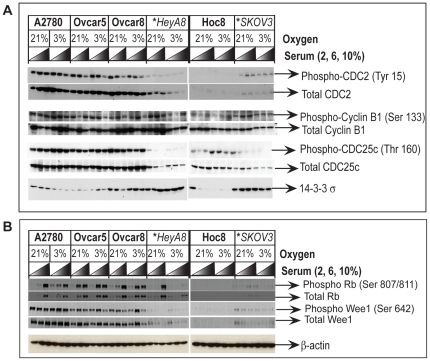
Western blot analysis of G2 cell cycle regulatory proteins and the relevance to O2 sensitivity in the ovarian cancer cell lines.Protein lysates prepared from the ovarian cancer cell lines maintained in growth medium consisting of increasing concentrations of serum and 21% or 3% O2 were analyzed by Western blot. (A) Compared to O2 sensitive cell lines, decreased expression of the core components involved in G2/M cell cycle progression CDC2/cyclin B1 complex and its activator CDC25c is observed in the O2 insensitive cell lines (indicated by asterisk and italics), while the expression of 14-3-3 σ, a protein that inhibits CDC2 is elevated in the O2 insensitive cell lines. (B) Phosphorylation of RB and Wee1 were monitored as an indicator for CDC2 function because both RB and Wee1 are known targets for phosphorylation by CDC2. Equal loading of protein extracts were monitored by probing the stripped Western blots with the primary antibody for β-actin.